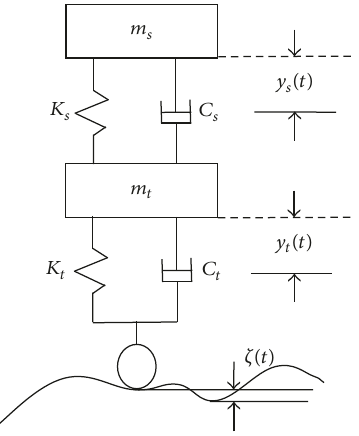
Figure 10: 1/4 vehicle suspension